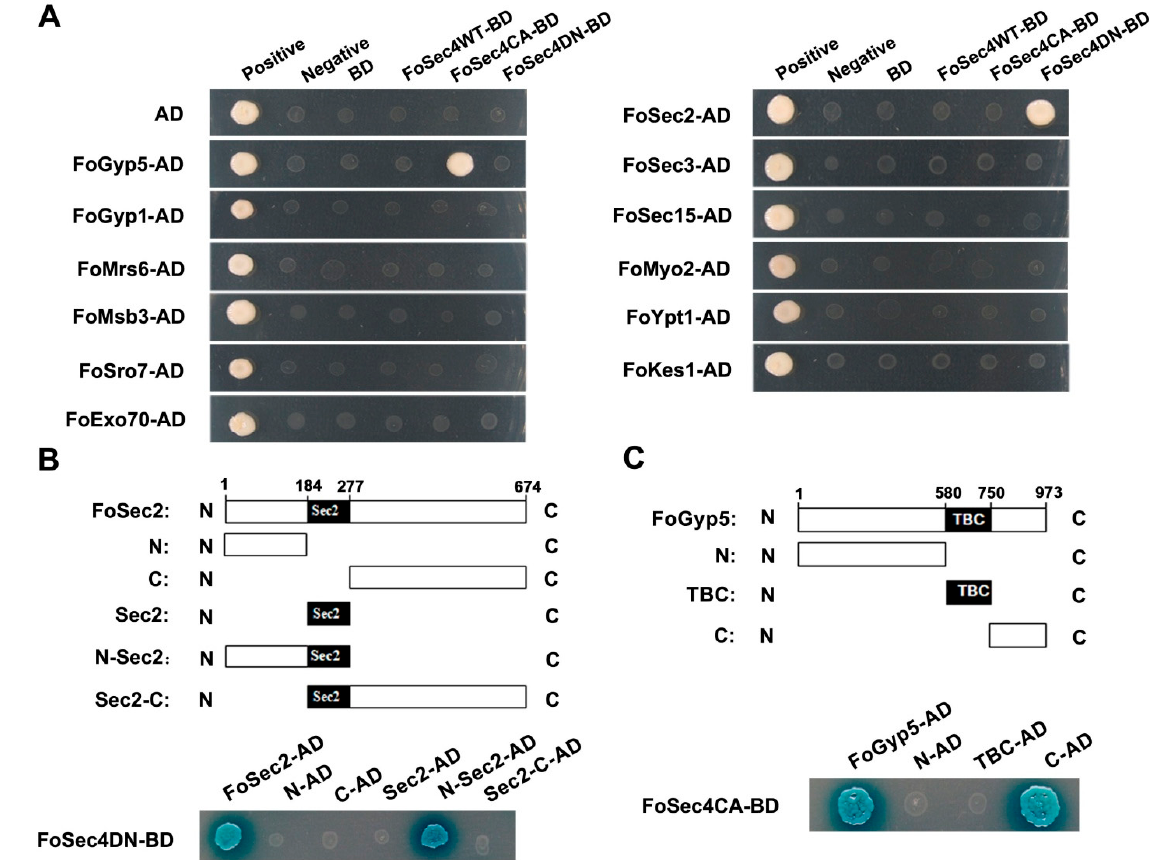
Figure 1. FoSec2 and FoGyp5 interact with FoSec4DN and FoSec4CA, respectively. ( A ) Yeast transformants expressing 12 proteins with FoSec4WT-BD, FoSec4CA-BD(Q69L) and FoSec4DN-BD(N123I) were grown on SD-Leu-Trp-His-Ade plates. FoSec2 specifically interacts with FoSec4DN, and FoGyp5 specifically interacts with FoSec4CA. ( B ) Schematic drawing of full-length FoSec2, the N-terminus, the C-terminus, the Sec2 domain, N-Sec2 and Sec2-C. The N-Sec2 region (amino acids 1–277) is essential for the interaction between FoSec2 and FoSec4DN. ( C ) Schematic drawing of FoGyp5-full length, the N-terminus, the C-terminus and the TBC domain. The C-terminus (amino acids 750–973) is essential for the interaction between FoGyp5 and